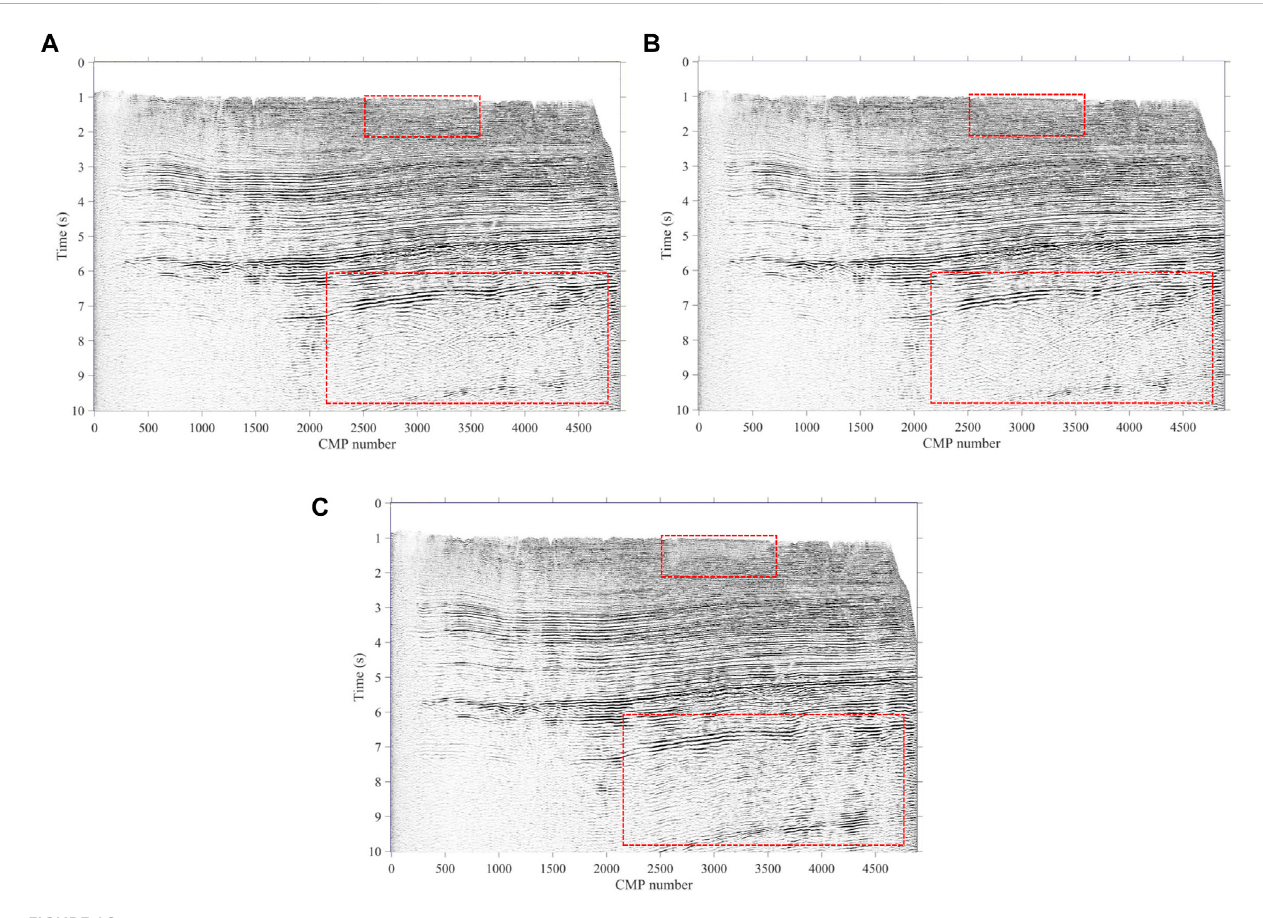
FIGURE 16 Stacking pro fi les of (A) manual, (B) method proposed, and (C) K-means.